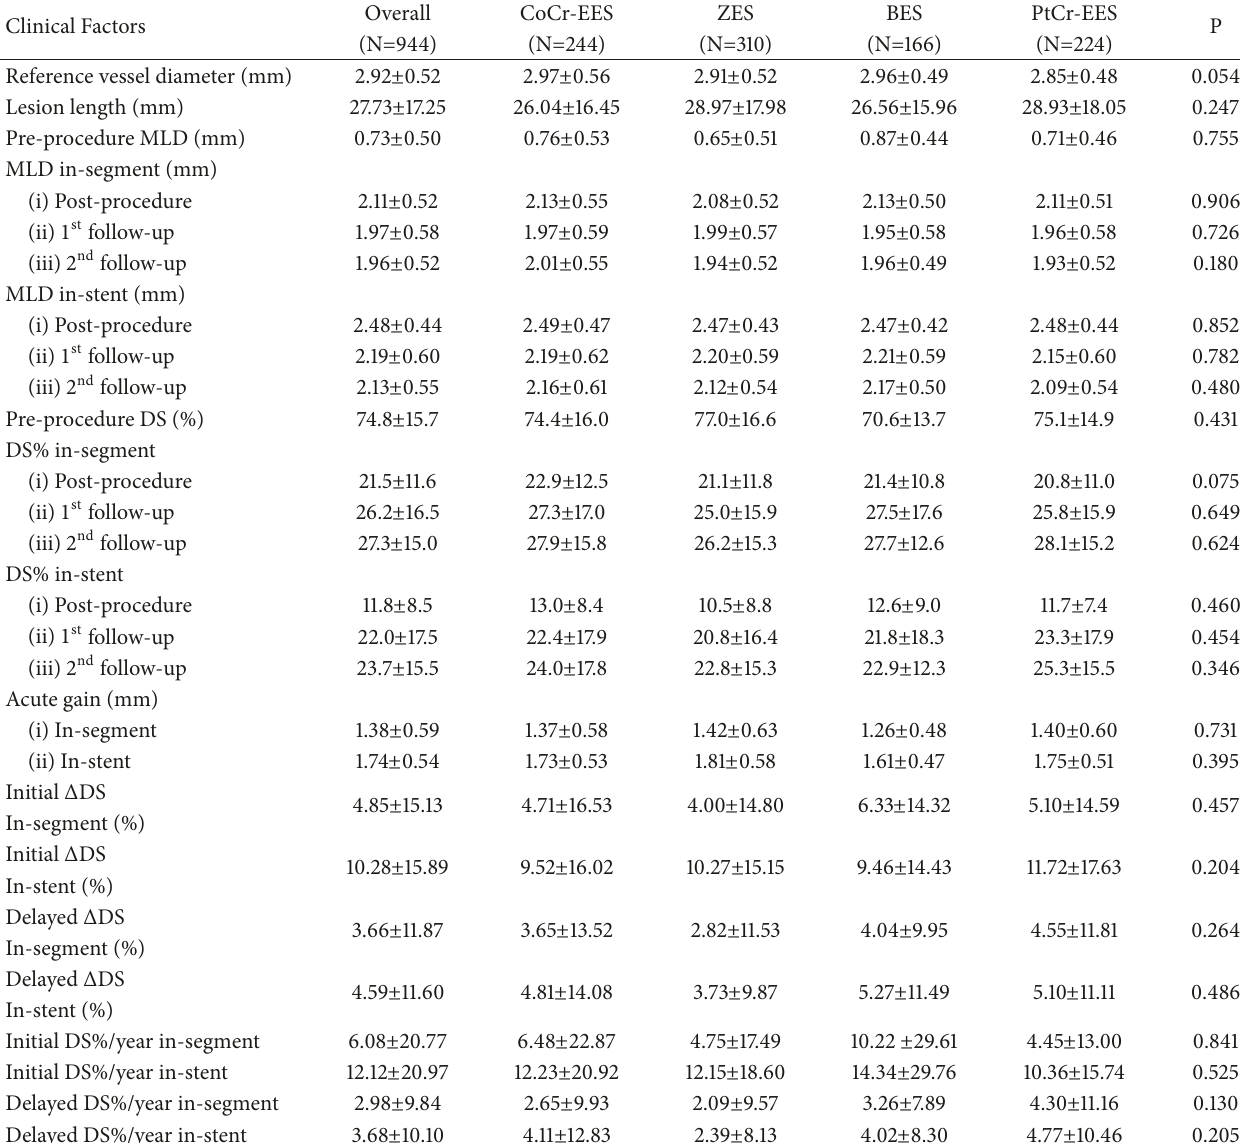
Table 5: Lesion characteristics and DS% progression rate according to types of